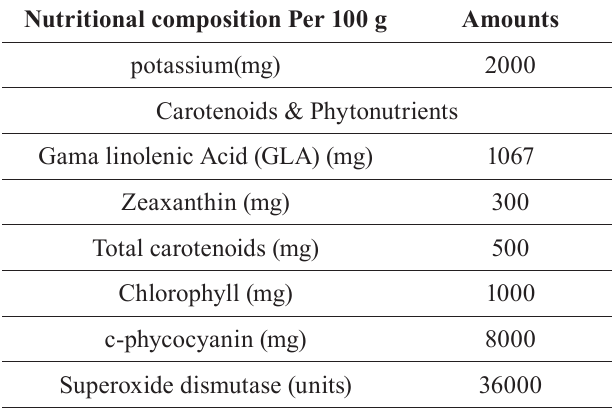
TABLE I - N utrition profile of spirulina